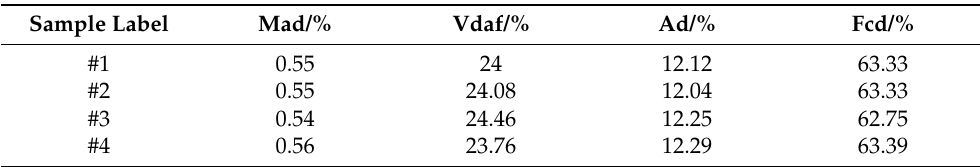
Figure 1. Raw coal sample for the experiment: ( a ) large pieces of raw coal from coal mine; ( b ) cylindrical coal samples; ( c ) the raw coal sample used in the experiment. Table 1. Proximate analysis results of dried raw coal samples.